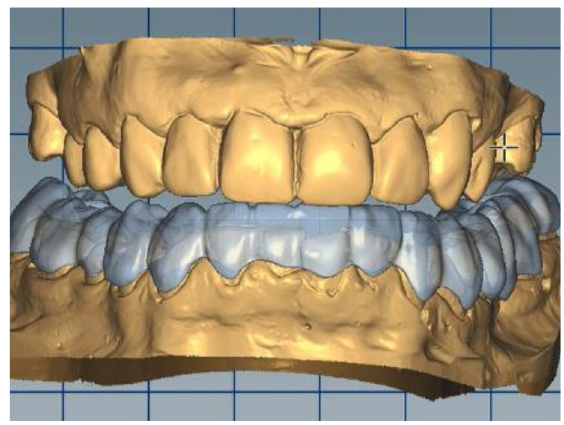
Figure 14. Splint design – anterior